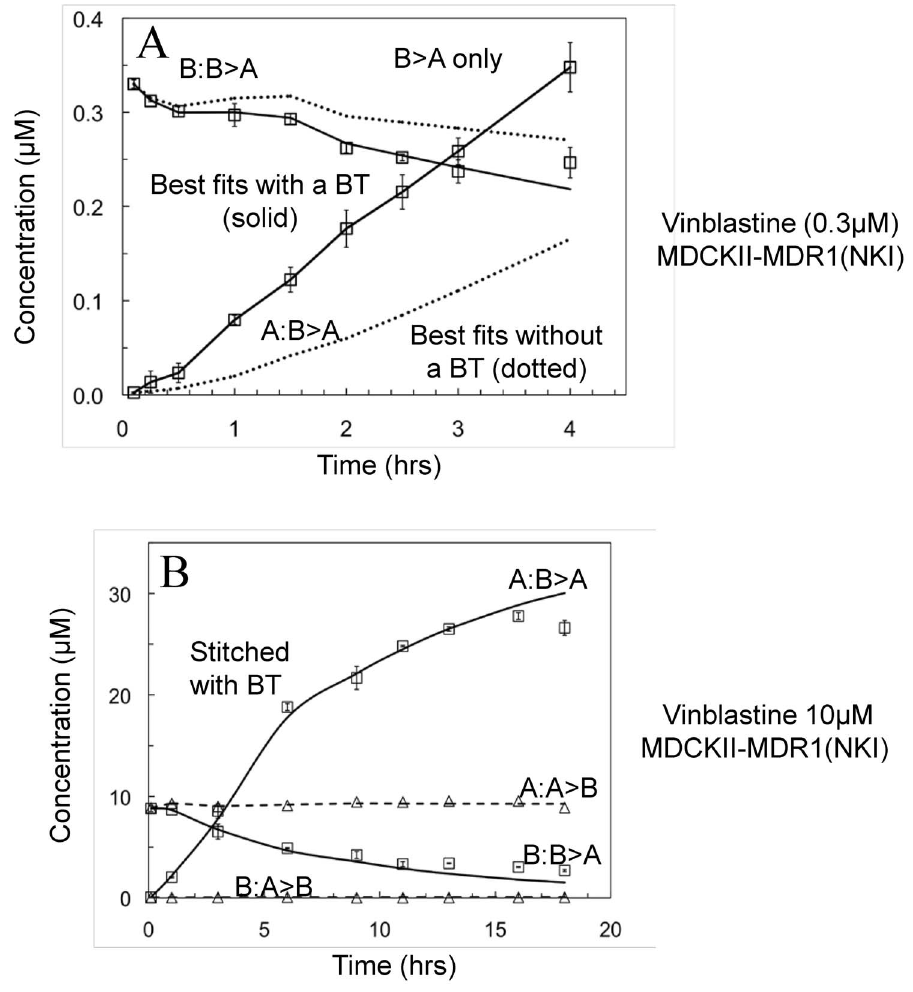
Figure 7. Transport data of vinblastine and their fitted curves across the MDCK-MDR1-NKI cell monolayers, data acquired at GSK. The same nomenclature is used as in Fig. 2. Fig. 7A shows the 6 hour experiment for 0.3 m M vinblastine. The dotted line shows the best fit with just P- gp inhibition. With BT, a good fit could be obtained, but not a unique fit, since the transport curves were essentially straight. Fig. 7B shows a stitched 18 hour experiment for 10 m M vinblastine, which was required to get unique fits for the kinetic parameters. The fitted parameters are shown in Table 2.